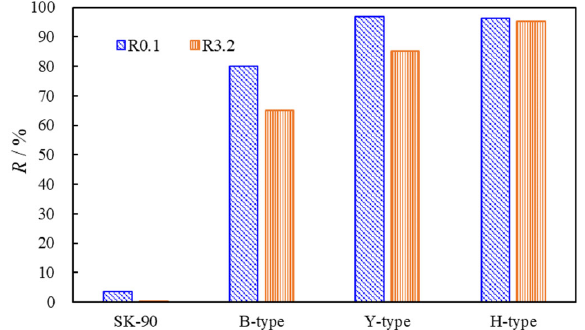
Figure 4. Creep recovery rate of different asphalt binders.